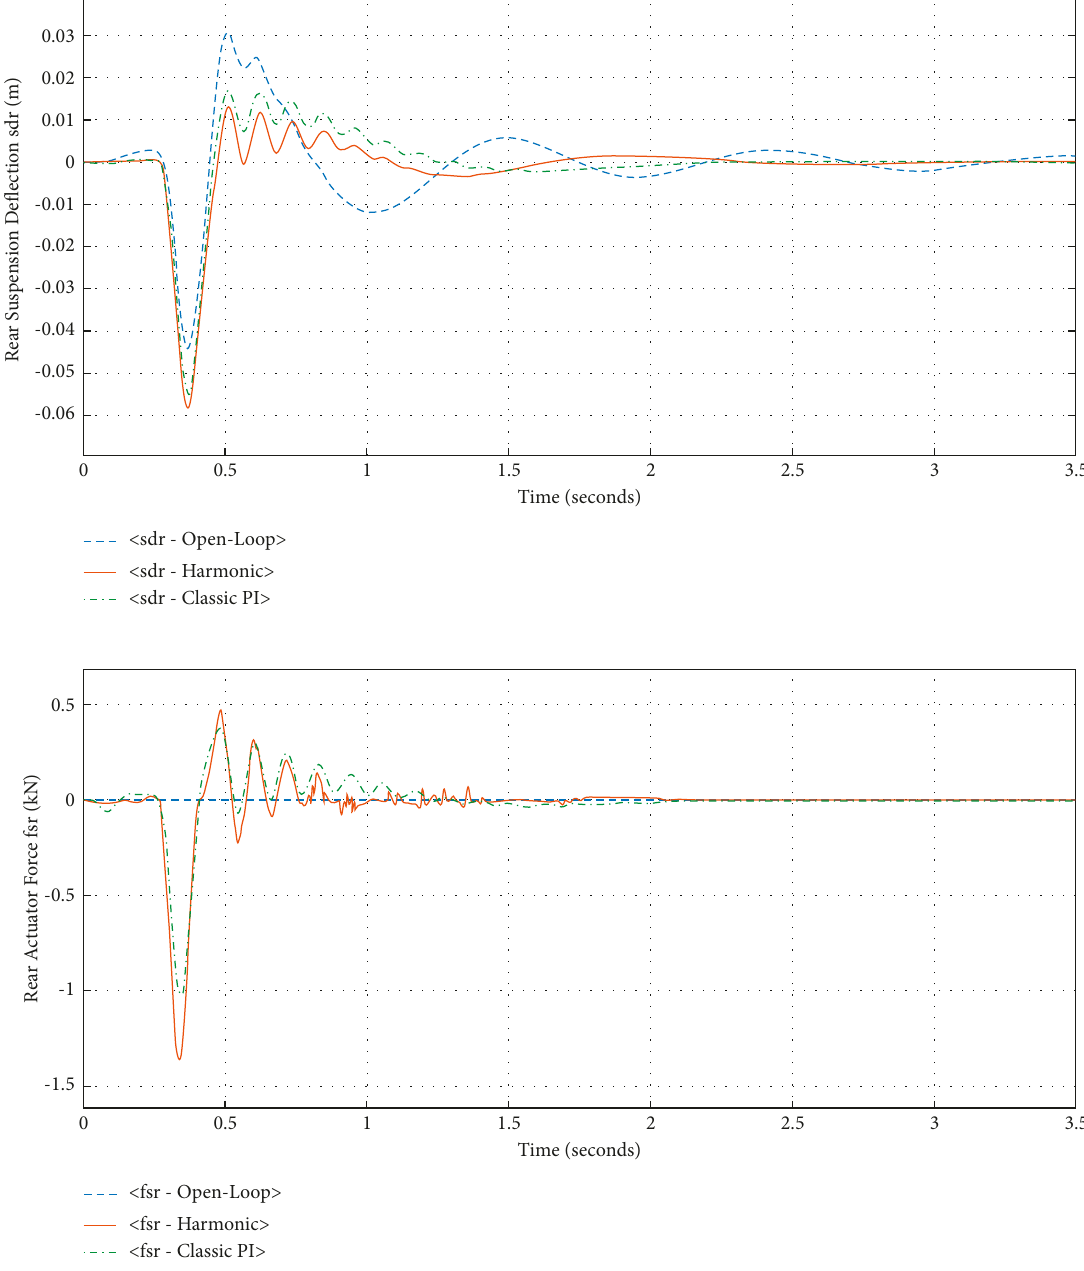
Figure 8: Rear suspension deflection s harmonic, green dash line means classic